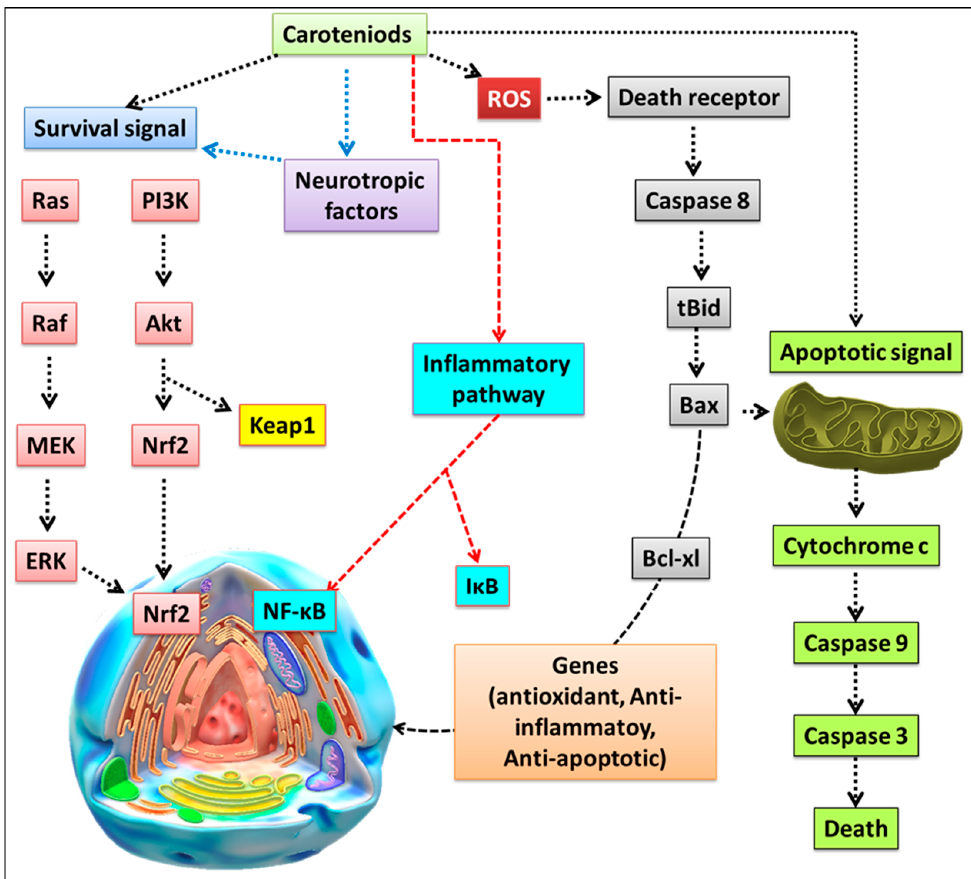
Figure 6. Carotenoids’ protective functions during neuronal death. Reactive oxygen species (ROS) can initiate apoptosis via the death receptor pathway and the mitochondrial route. (Reactive oxygen species (ROS); mitogen-activated and extracellular-signal-regulated kinase kinases (MEK); extracellular-signal-regulated kinases (ERK); nuclear factor (erythroid-derived 2)-such as 2 (Nrf2); impaired antioxidant (Keap1); small Maf proteins (sMaf); antioxidant response element (ARE); phosphoinositide 3-kinase (PI3K); protein kinase B (Akt); nuclear factor- κ B (NF- κ B); membrane-targeted death ligand (tBid); apoptosis regulator (BAX); B-cell lymphoma (Bcl-xl)).